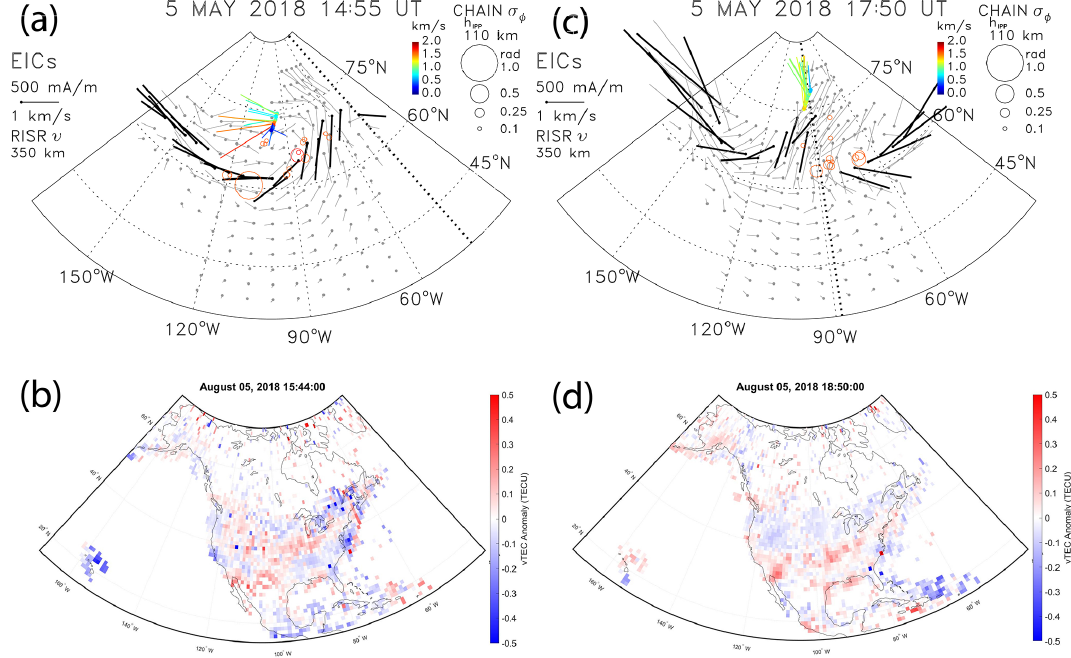
Figure 14. Panels (a–b) show the horizontal EICs with the latitudinal maxima at each longitude grid highlighted in bold and the CHAIN GPS IPPs with enhanced phase-variation values, σ (cid:56) (scaled circles). Panels (c–d) represent the detrended vTEC maps showing LSTIDs at later times on 5 May